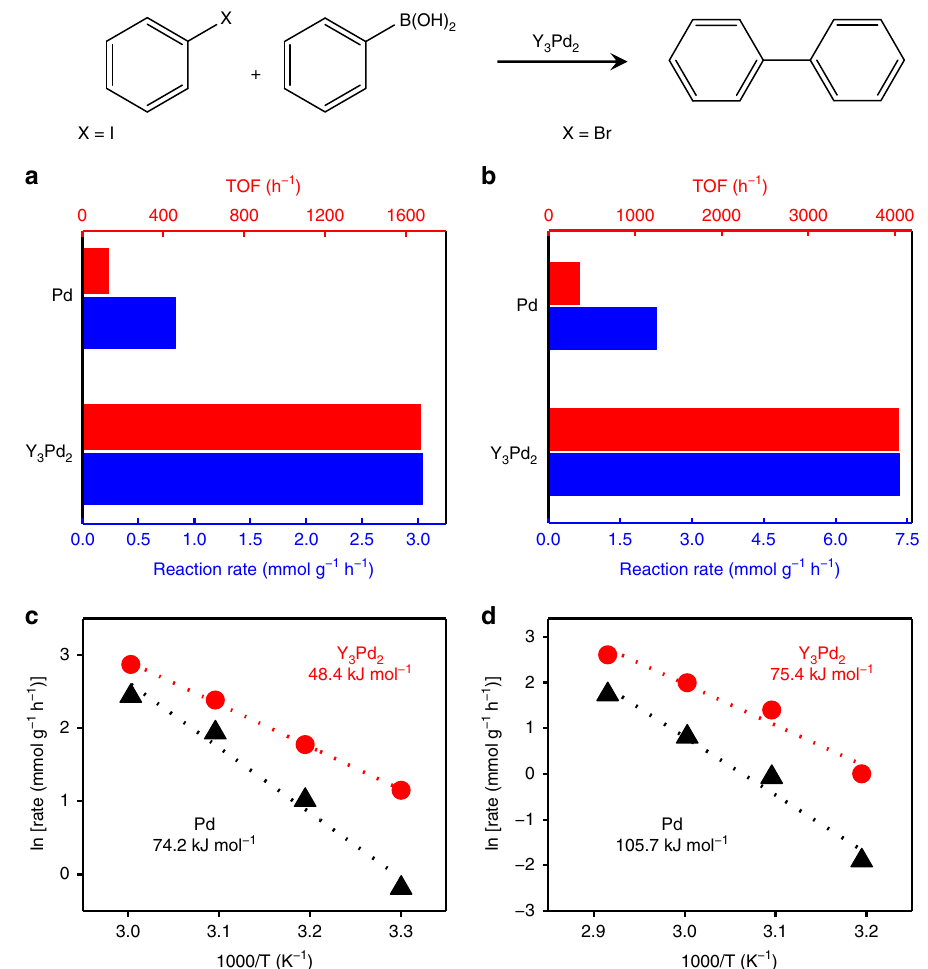
Fig. 2 Catalytic performance and kinetic analysis for Suzuki coupling reactions. a , b Suzuki coupling reaction rates (blue bars) and TOFs (red bars) over Y 3 Pd 2 and pure Pd metal catalysts. c , d Apparent E a s for the Suzuki coupling reaction over Y 3 Pd 2 and pure Pd metal catalysts. Reaction conditions: Pd (40 mol% relative to organohalide); 0.5 mmol organohalide, 0.8 mmol phenylboronic acid, 1.5 mmol K 2 CO 3 , 5 ml solvent, iodides 30 °C, bromides 60